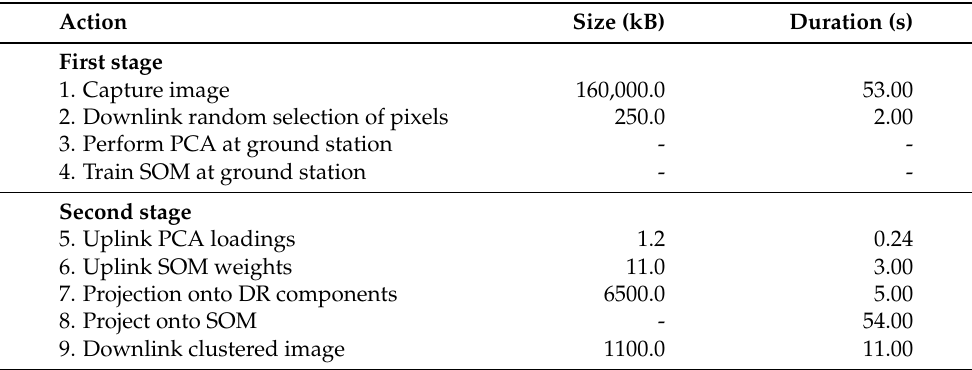
Table 4. The two-stage procedure for data